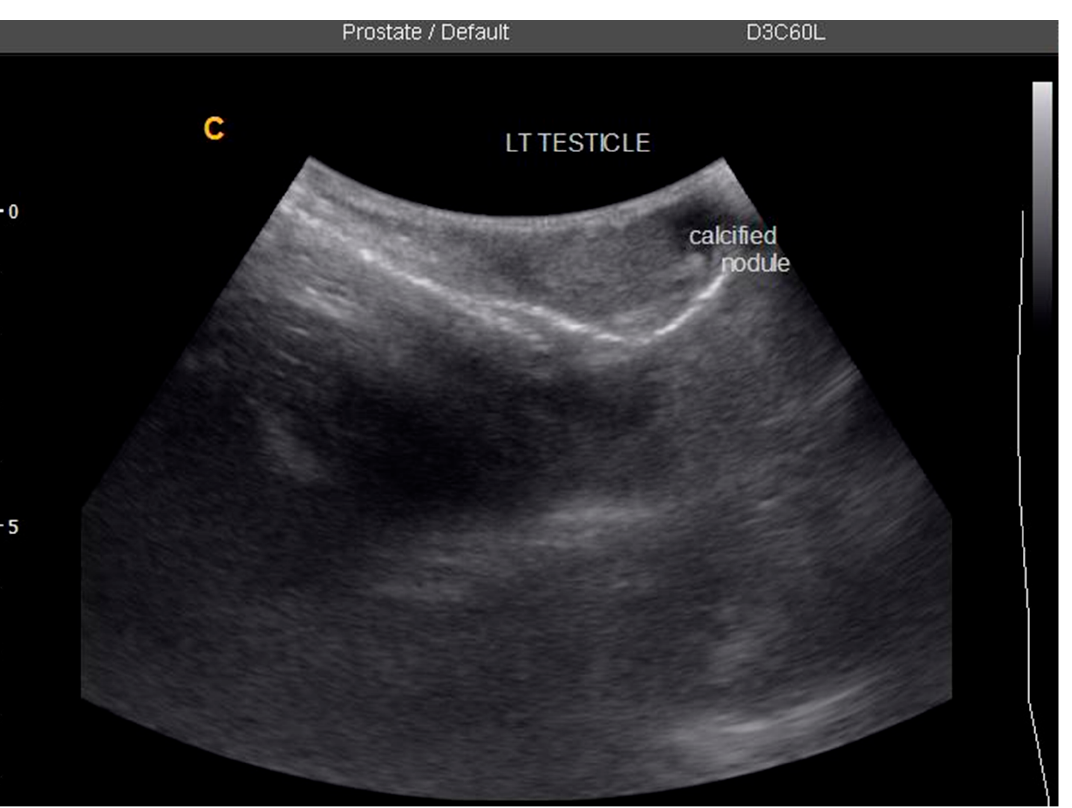
Table 4. Observations on ultrasonography of one participant at baseline and one-month follow- up.